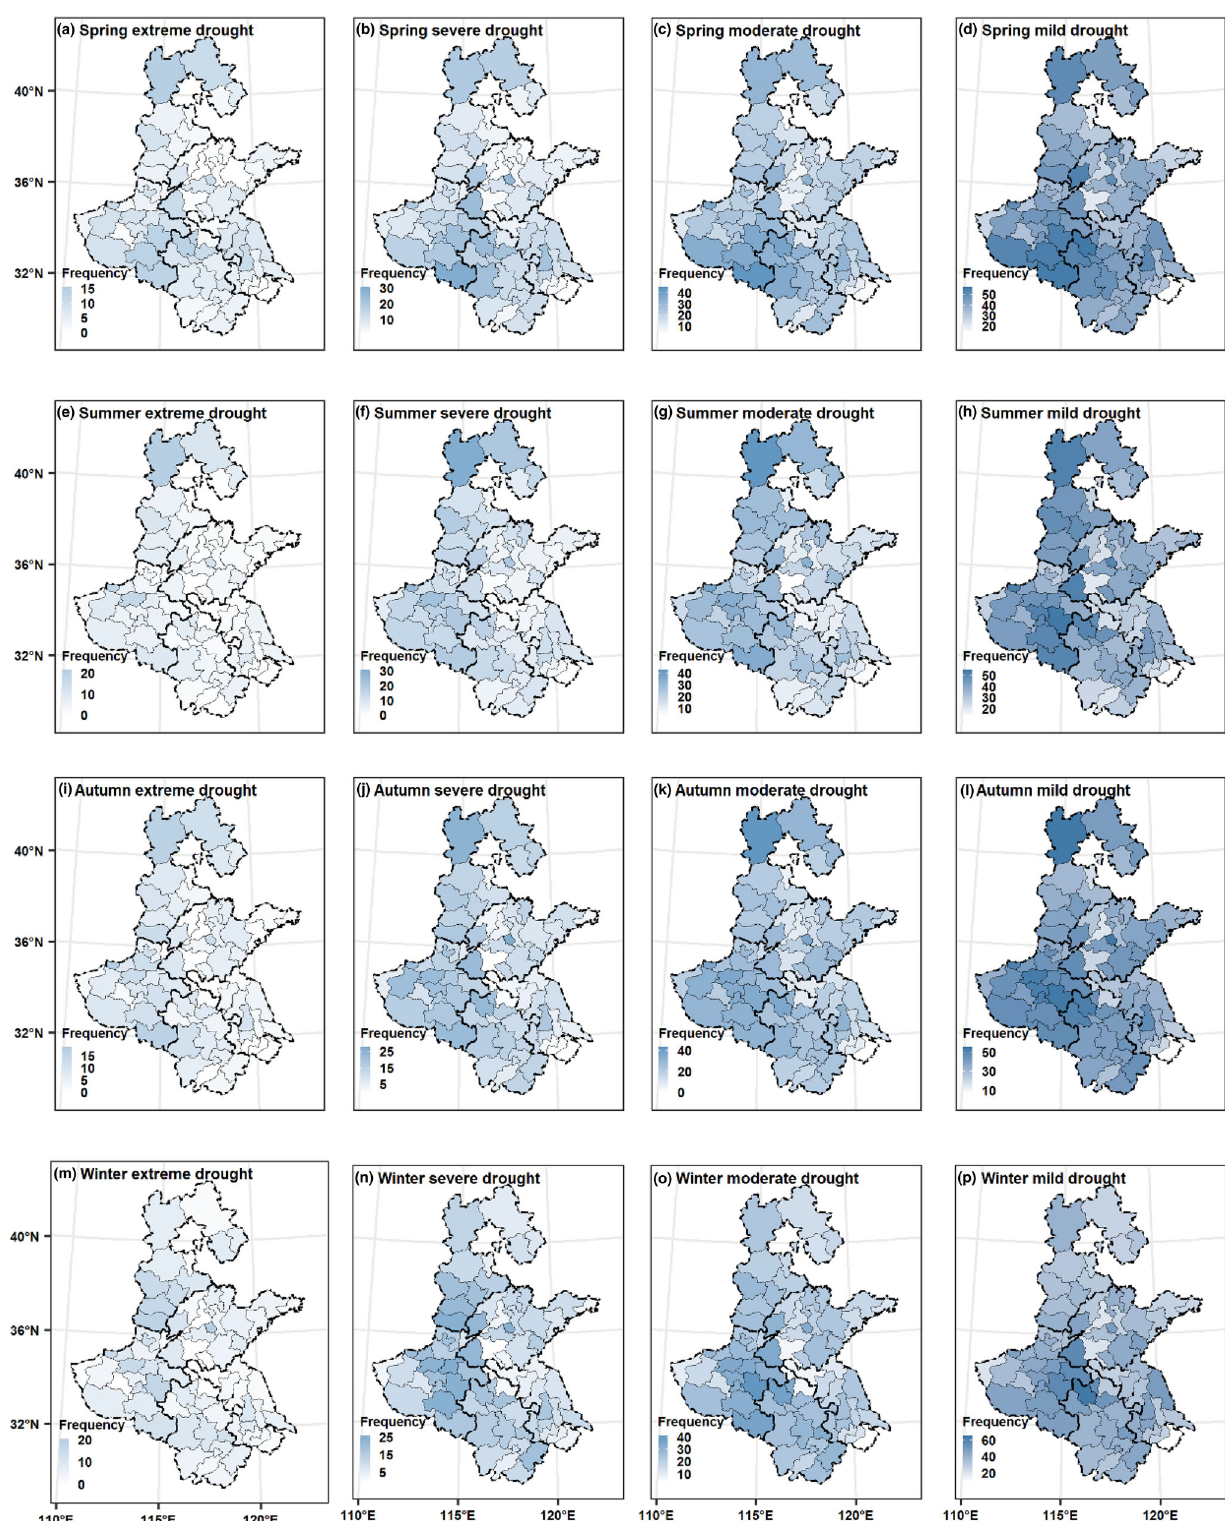
Fig. 5 Spatial distribution of the frequency of droughts of different intensities in Anhui, Hebei, Henan, Jiangsu, and Shandong Provinces, China,